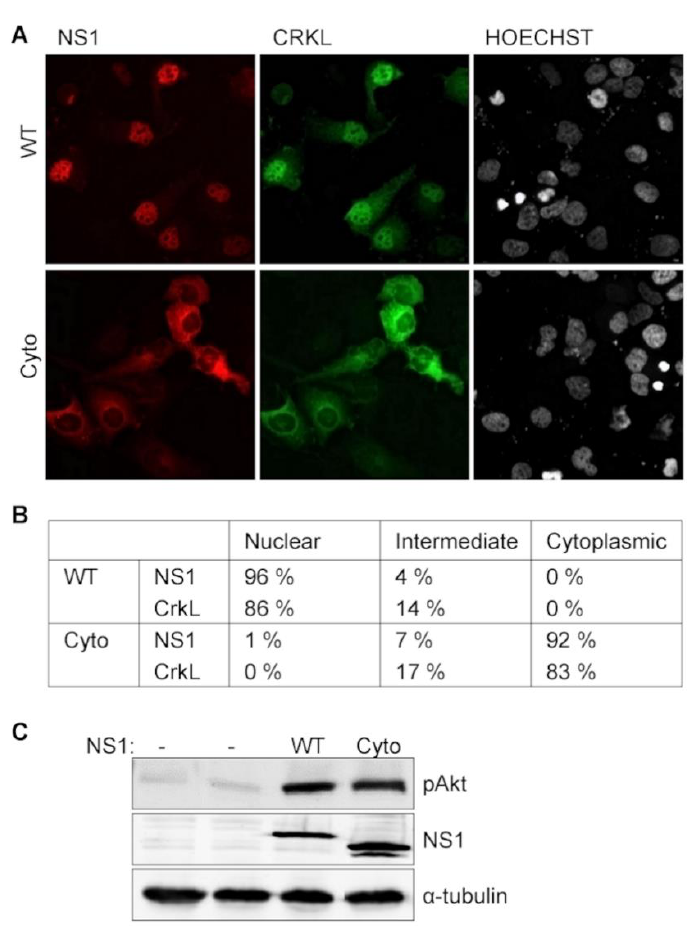
Figure 4. NS1-mediated Crk relocalization is independent of NS1-activated PI3K-signaling. ( A ) Fluoresence microscopy imaging of Huh7 cells co-transfected with eGFP-fused CrkL (green (WT) or its dominantly cytoplasmic mutant NS1-Cyto; ( B ) Localization of NS1 and CrkL was examined or cytoplasmic; ( C ) PI3K-activation by wild-type and mutant version of NS1 revealed by Akt phosphorylation. Huh7 cells were transiently transfected with a vector expressing the indicated NS1 variants, and 48 h later examined by Western blotting with antibodies against phospho-Akt (pAkt), NS1, and α